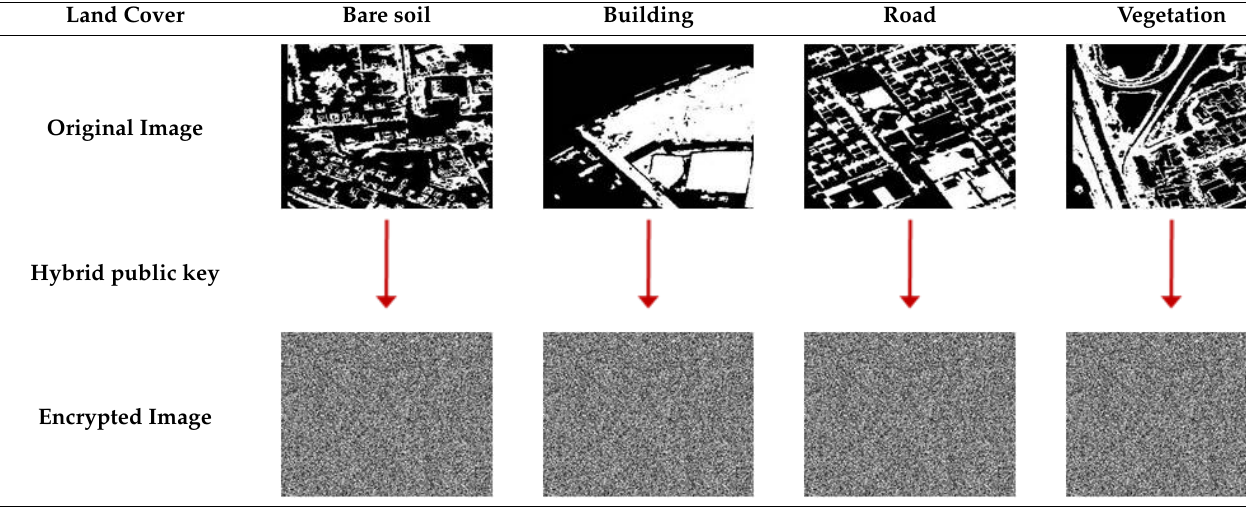
Figure 7. Land cover images belonging to the four different classes and their encrypted